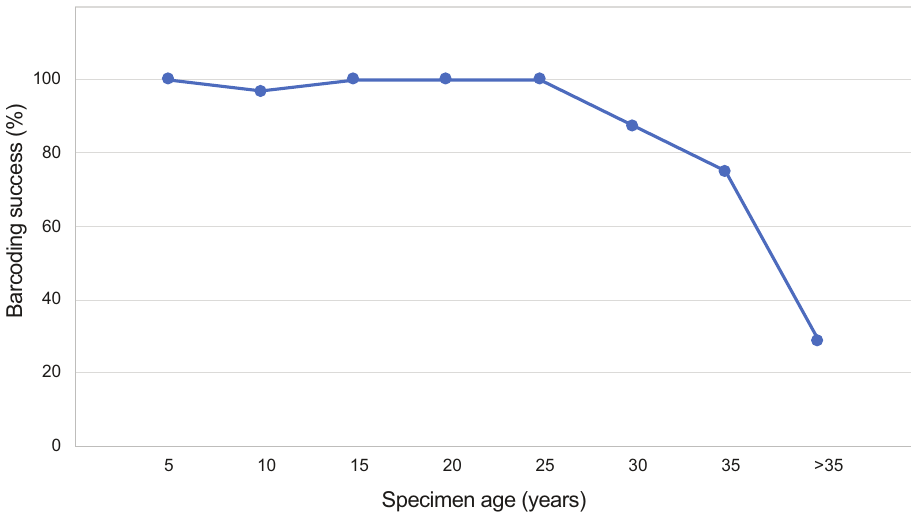
Figure 1. Relationship between barcoding success, as indicated by the proportion of specimens that yielded at least a diagnostic, 180-bp “mini-DNA barcode”, and the age of the